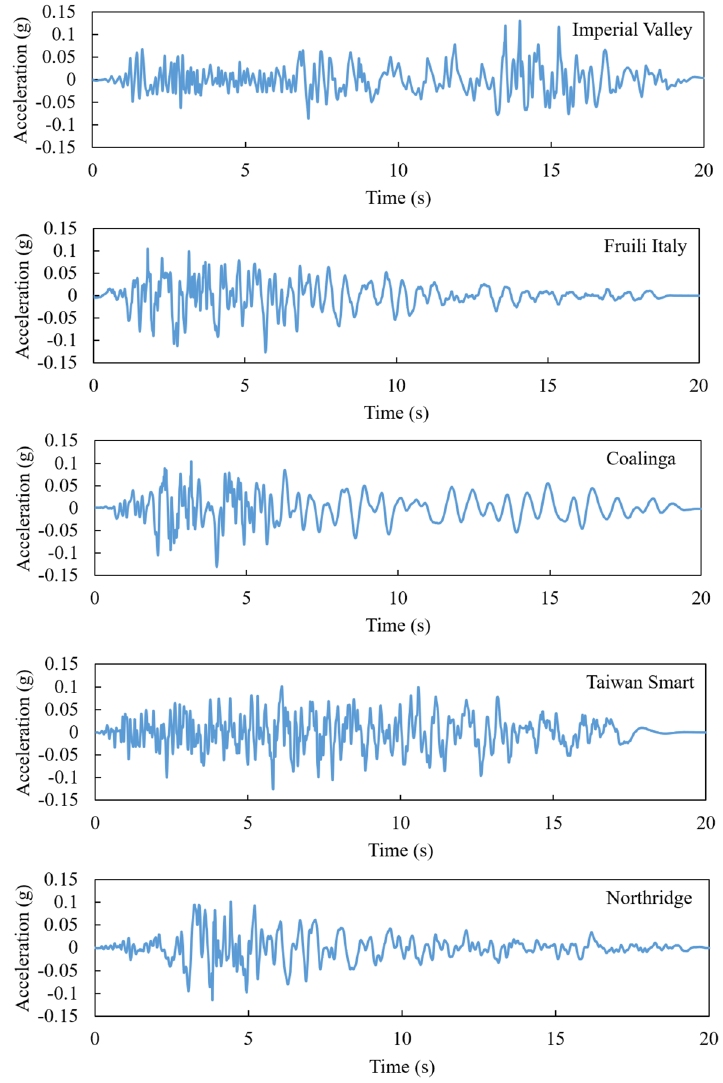
Fig. 3 Outcrop rock acceleration time histories of five earthquake motions after matching with the Vietnamese standard design spectrum for the target PGA of 0.11